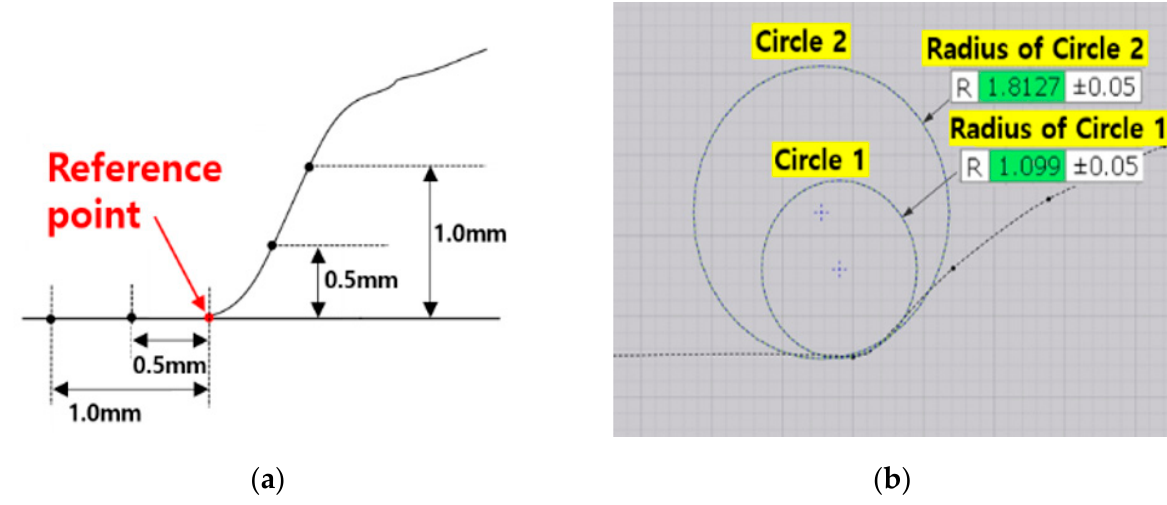
Figure 18. Schematic diagram and an example of radius measurement: ( a ) range for measuring radius at the reference point; ( b ) example of measured radius for two ranges.